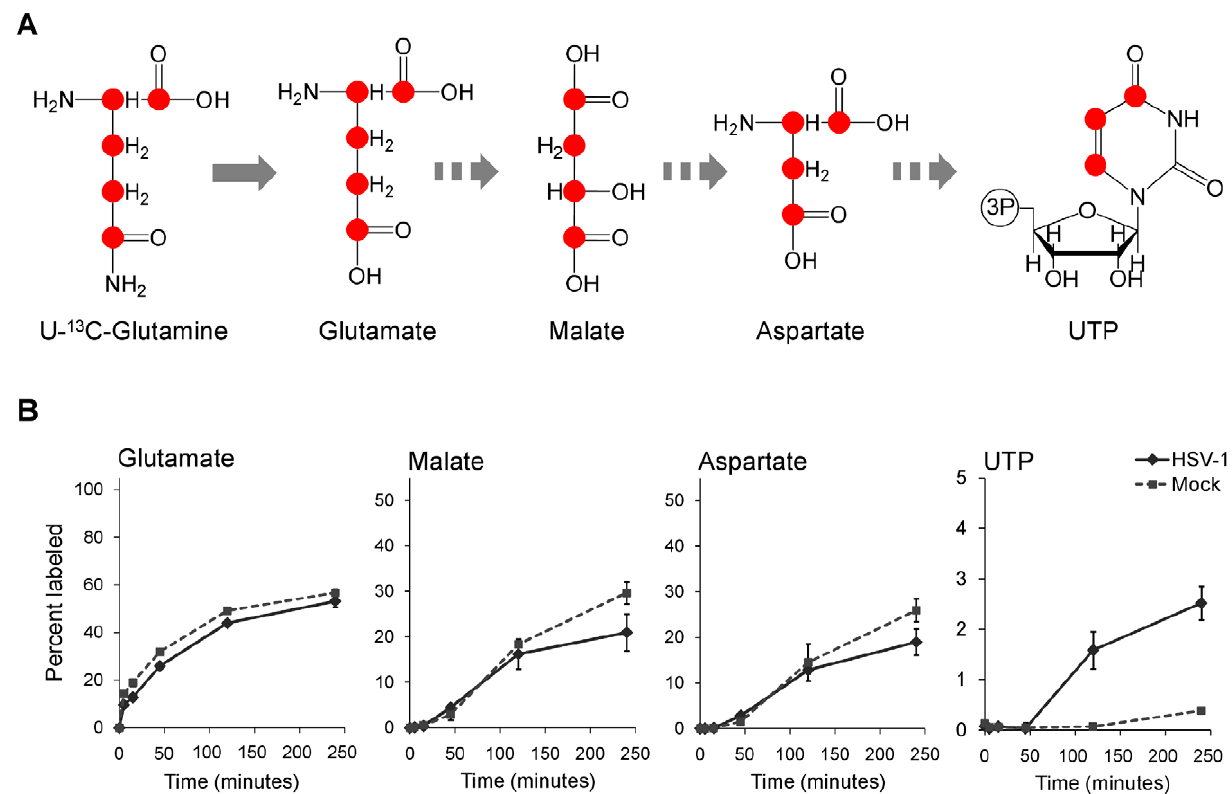
Figure 6. Flux to pyrimidine nucleotide synthesis induced by HSV-1 infection. ( A ) Schematic of carbon labeling from glutamine to UTP arising during carbon influx from glutamine to the TCA cycle. Red dots denote 13 C atoms originating from uniformly 13 C-labeled glutamine. ( B ) Plots show the levels of the labeled form of the indicated metabolites expressed as percent of the total metabolite pool. The labeling arose upon switching HSV-KOS infected or mock treated HFF cells to uniformly 13 C-labeled glutamine media. HCMV infected cells were switched at 48 hpi, HSV-1-infected cells at 12 hpi. The x-axis indicates time post media switch (mean 6 2 s.e.; n=2).